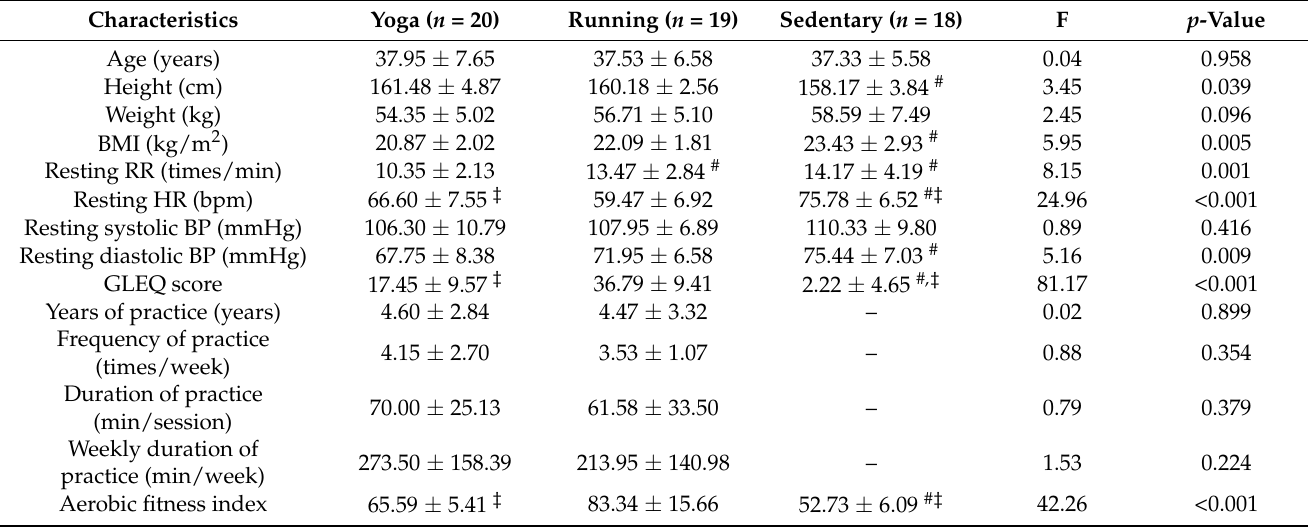
Table 1. Characteristics of the